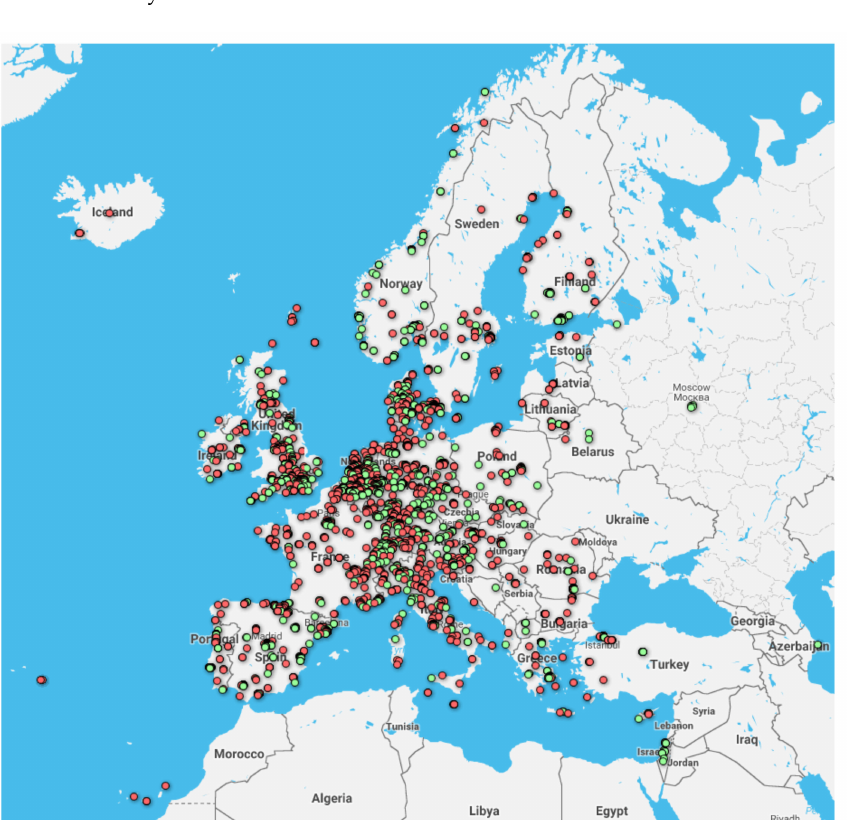
Figure 5. Distribution of smart grid projects in Europe, Source: